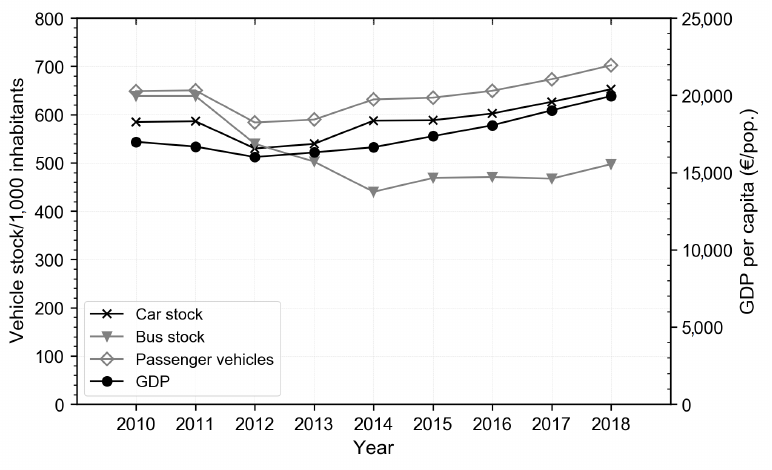
Figure 7. Car and bus stock trend versus GDP (data on supplementary